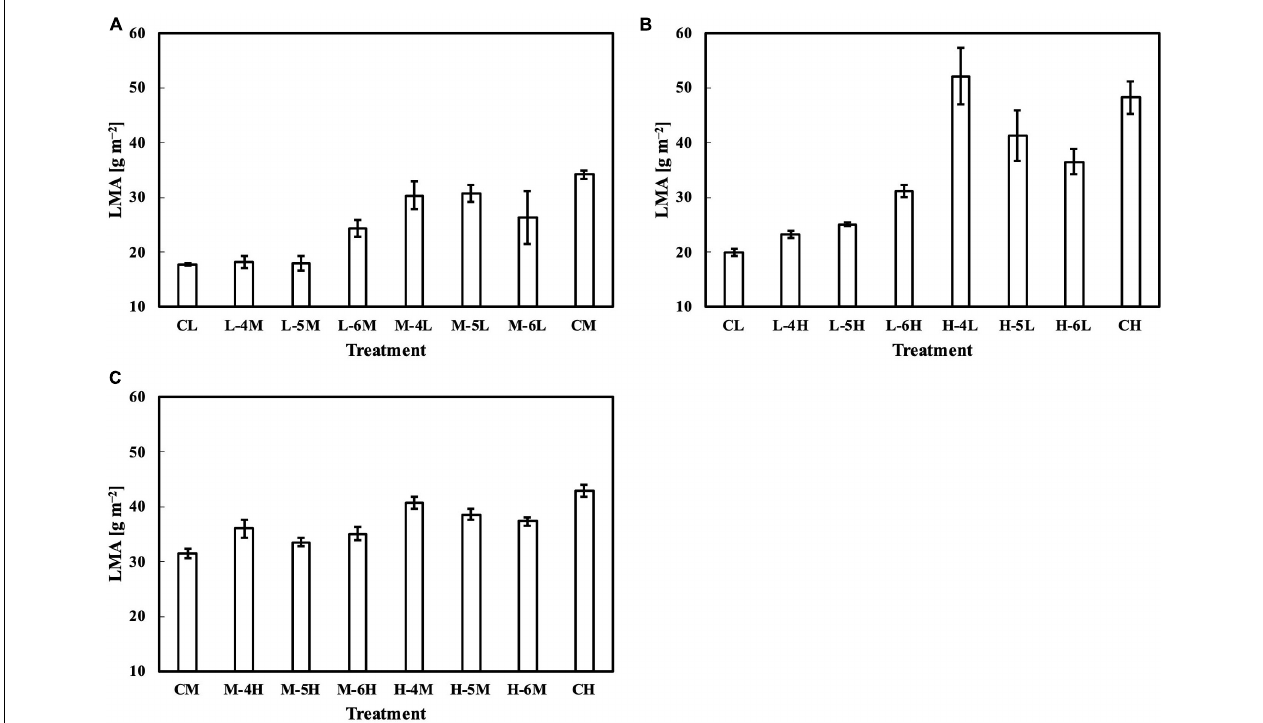
FIGURE 6 | LMA of leaves subjected to a PPFD for 1 day different from the basal PPFD in the other days. CL and CM: treatments with a constant PPFD of 100 and 400 µ mol m − 2 s − 1 , respectively. The experiment was divided into three groups (A–C) and conducted separately due to limited experimental capacity. Values were means ± standard errors ( n = 3). L–4M: treatment with a PPFD of 400 µ mol m − 2 s − 1 in the fourth day of treatment period and a basal PPFD of 100 µ mol m − 2 s − 1 in the other 5 days. See Supplementary Table 2 for details of treatments.